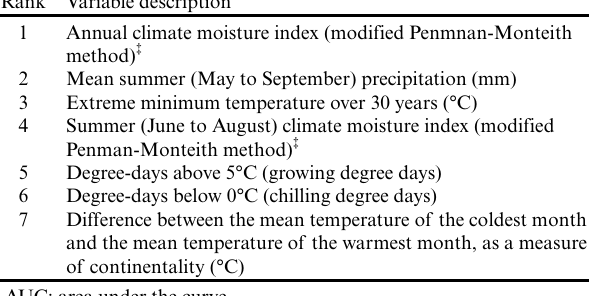
Table 2 . Ranked predictor variable importance across all 15 species, determined from the ranked bootstrap-averaged single variable AUCs † for each